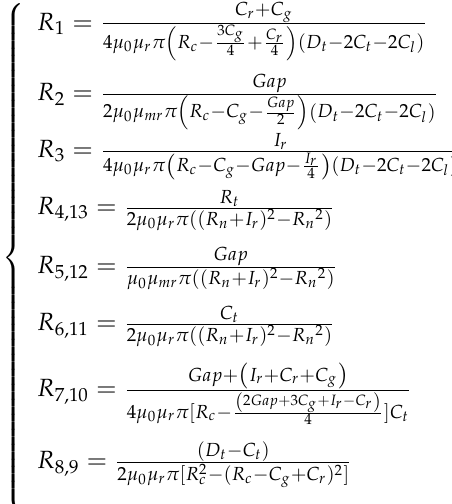
Table 3. The comparison of fi nite element simulation and modeling calculation results of axial sin- gle-coil con fi guration.